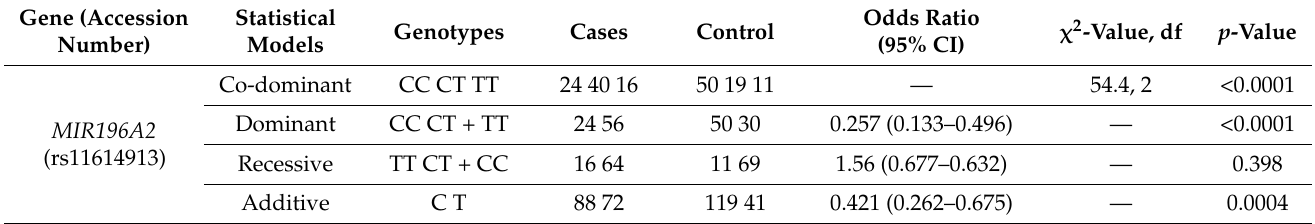
Table 3. Inheritance models for investigating the association of rs895819, rs11614913, and rs2168518 with